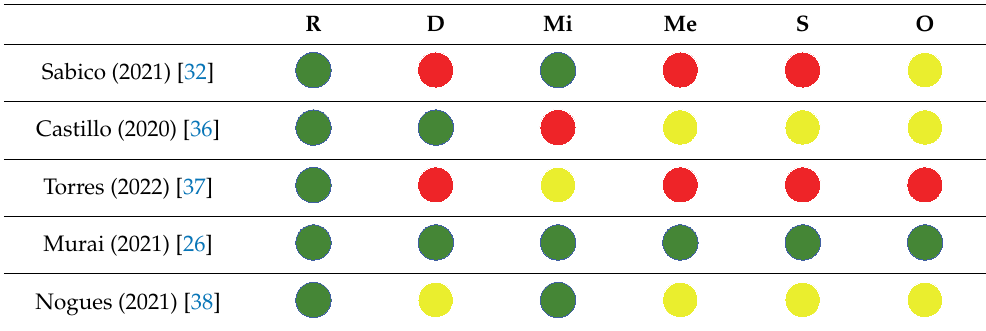
Legend: R—bias arising from the randomization process; D—bias due to deviations from intended interventions; Mi—bias due to missing outcome data; Me—bias in measurement of the outcome; S—bias in selection of the reported results; O—overall risk of bias; + low risk of bias; − high